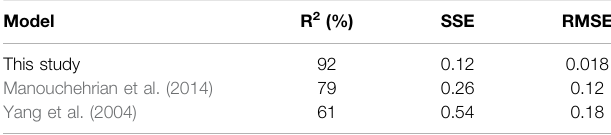
TABLE 5 | The statistical assessments of the responses for model 2 with other models. Model R 2 (%)